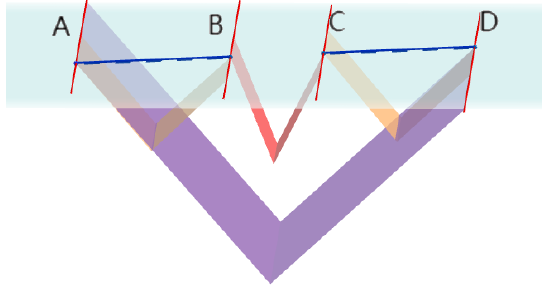
Figure 11 . This cartoon picture shows the pre-entanglement wedge nesting property in AdS 3 /WCFT holography. For two (blue) disjoint boundary intervals AB and CD , the region bounded by the yellow null surfaces and (cyan) cutoff surface corresponds to the disconnected W wedge related to single interval BC are bounded by red null surfaces, and the one related to interval AD are bounded by purple null